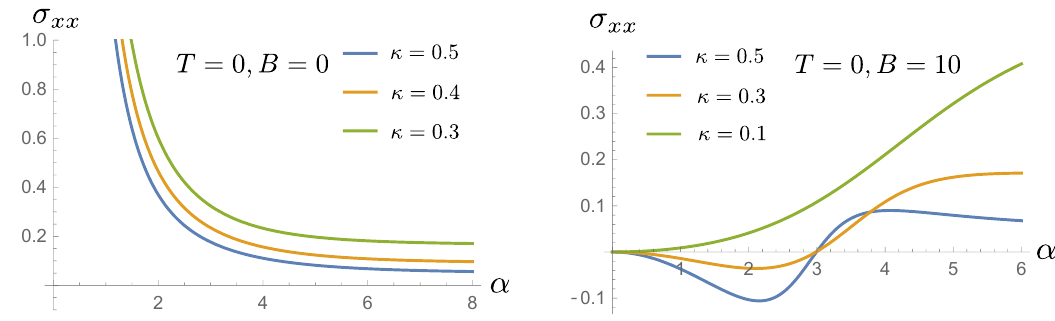
Figure 1 . Plots of the DC conductivity for the Exponential model without a magnetic (cid:12)eld (left) and with a magnetic (cid:12)eld (right). We (cid:12)x T = 0 and vary (cid:11) for di(cid:11)erent choice of coupling constant (cid:20) . In the present of magnetic (cid:12)eld, there is a region with negative (cid:27) xx developing when (cid:20) is large but still lies in the healthy region proposed by [27]. We have worked in units with the charge density (cid:26) =